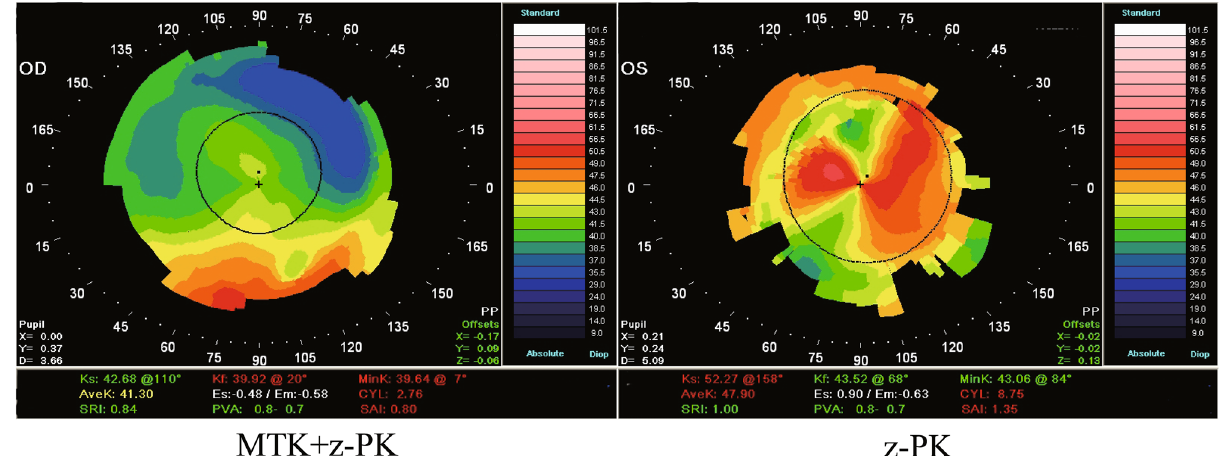
Figure 3. Corneal topography images of the smallest SRI in the MTK + z-PK group (left-side image) and z-PK group (right-side image). There were fewer irregularities of corneal shape in the MTK + z-PK group than in the z-PK group.